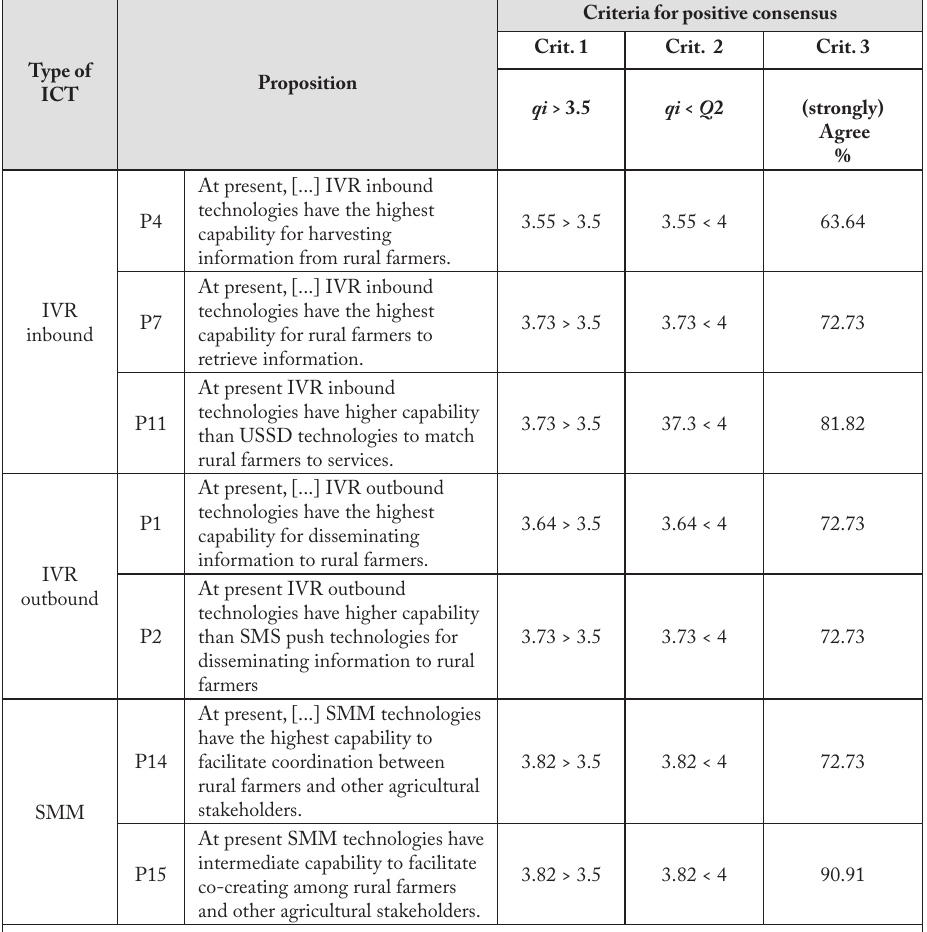
Table 6: Propositions associated with positive consensus